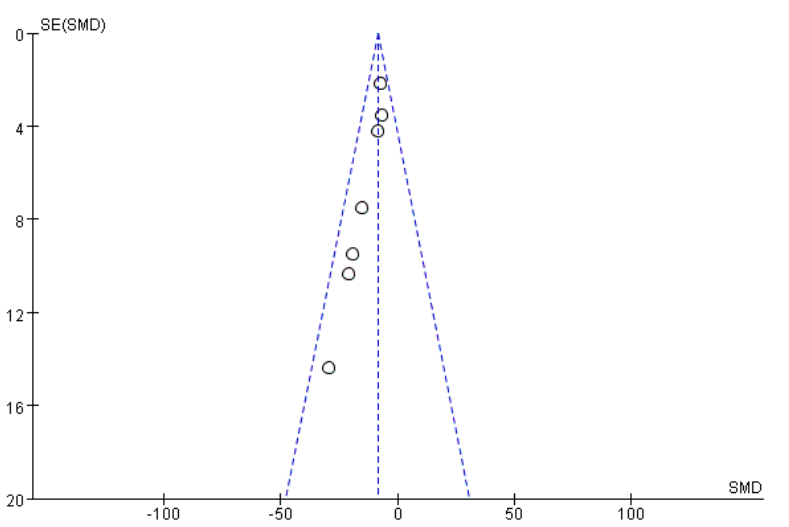
Figure 18. Funnel plot of studies evaluating antioxidant activity of S. crispa.